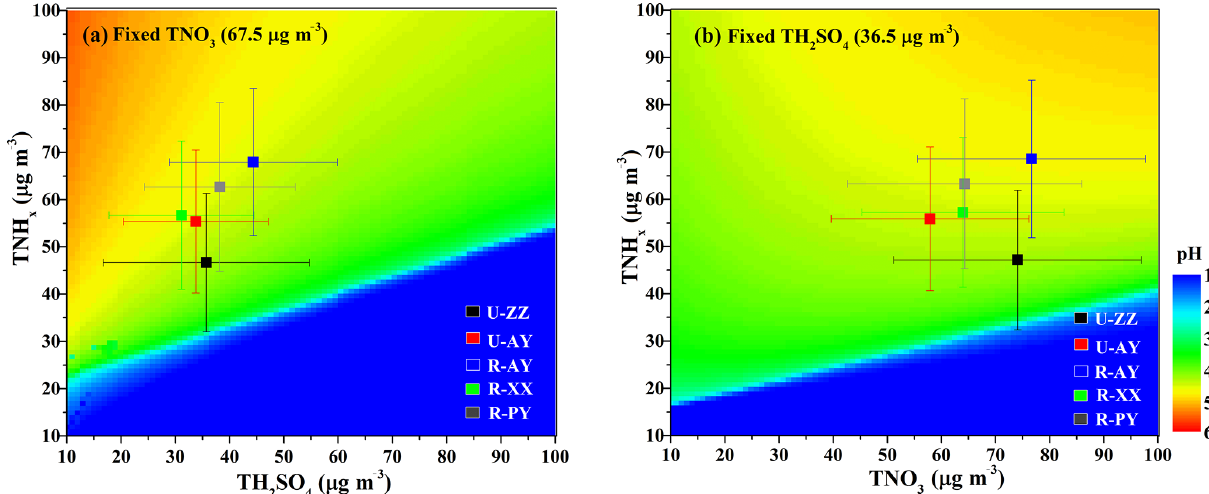
Figure 6. Particle pH calculated with fixed meteorological parameters ( T = 275 . 5K and RH = 60%) under different combinations of T NH x and (a) T H 2 SO 4 (Fixed T NO 3 = 67 . 5µgm − 3 ) and (b) T NO 3 (Fixed T H 2 SO 4 = 36 . 5µgm − 3 ). The color scale bar represents the pH values. The markers on the graph represent the average concentrations of T NH x , T H 2 SO 4 , and T NO 3 at the five sites during Case 2 with standard deviation as error